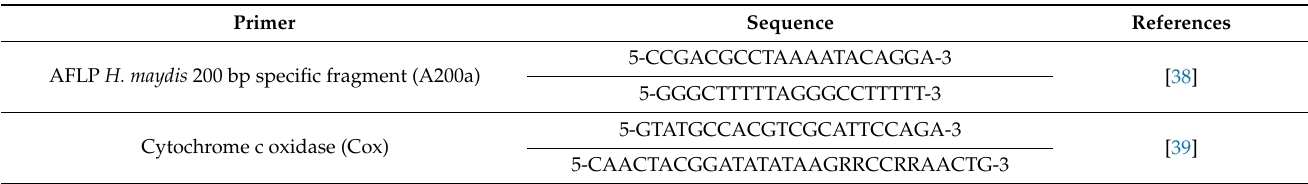
Table 1. Primer pair sequences for qPCR and H. maydis detection.